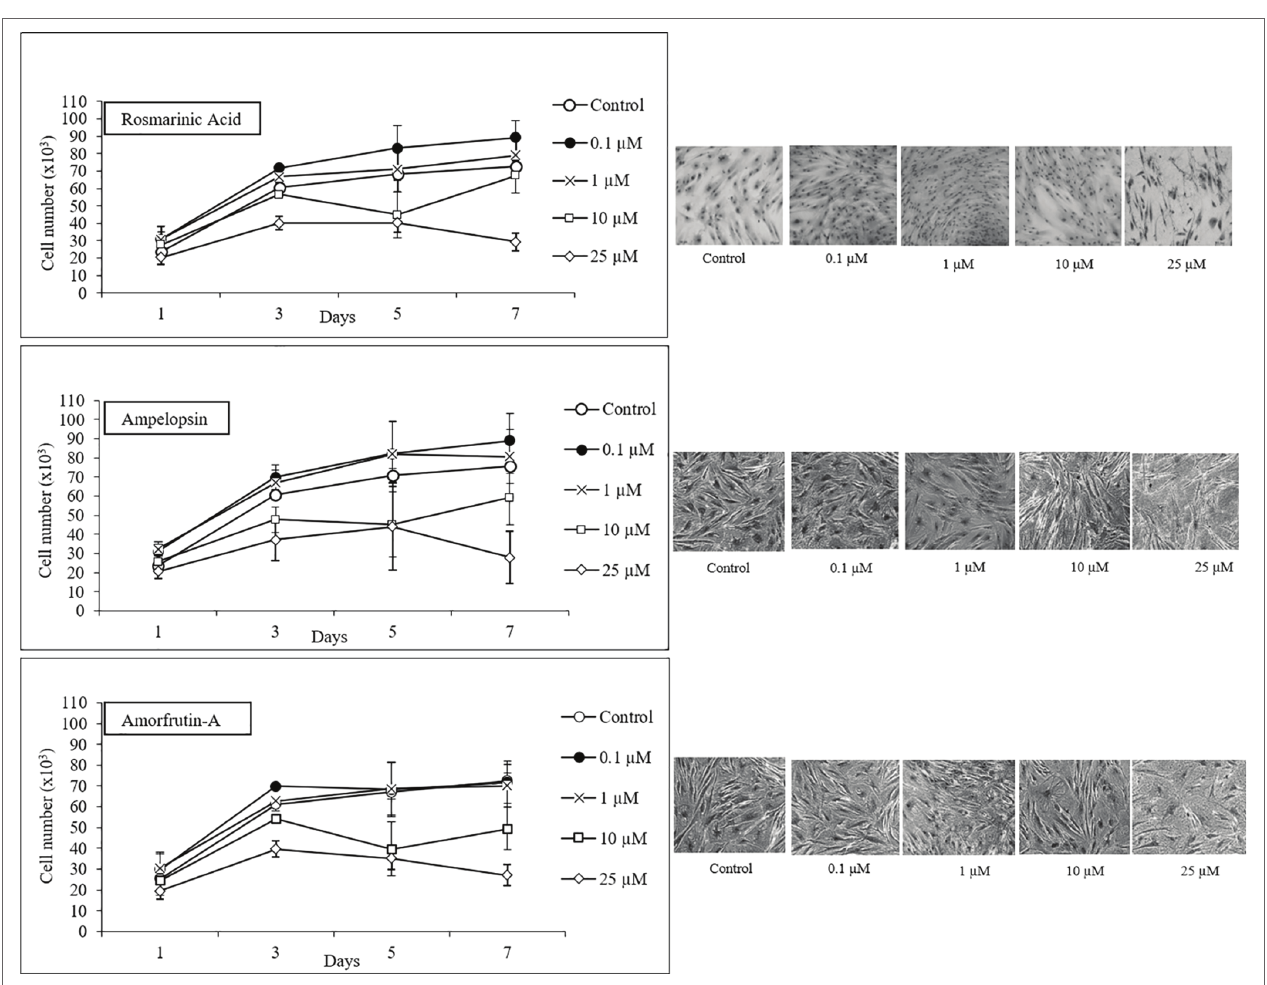
FIGURE 3 | One-step growth curves and cell morphology of early passage PCS cells (p20) exposed to different concentrations of test compounds over a period of 7 days; n = 3; ±SEM; and photographs of Giemsa stained cells at microscopic magnification